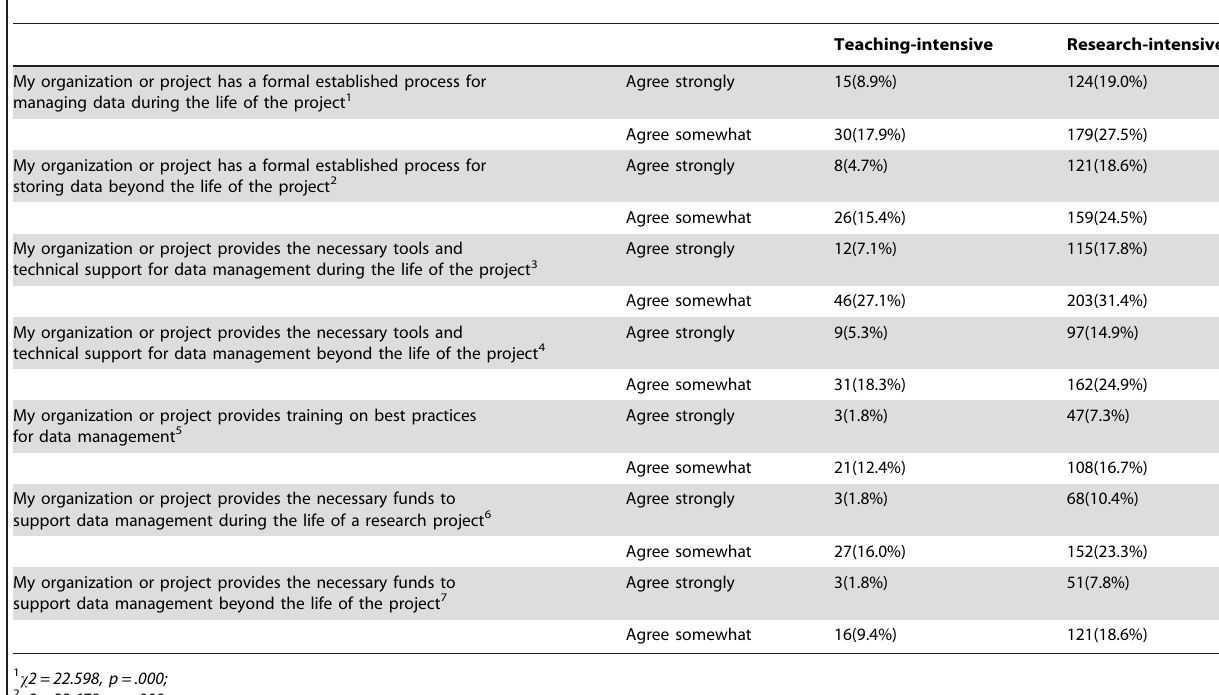
Table 30. Organizational involvement by